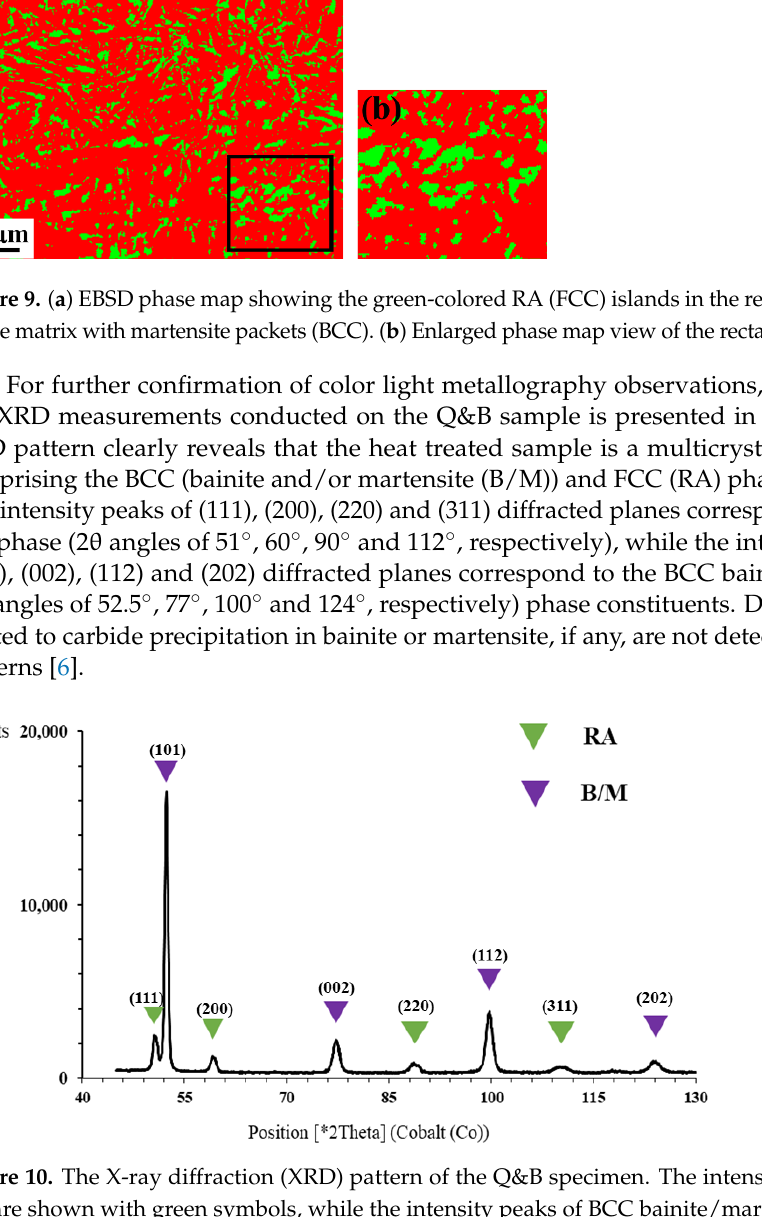
Figure 10. The X-ray diffraction (XRD) pattern of the Q&B specimen . The intensity peaks of FCC RA are shown with green symbols, while the intensity peaks of BCC bainite / martensite (B/M) are shown with purple symbols.